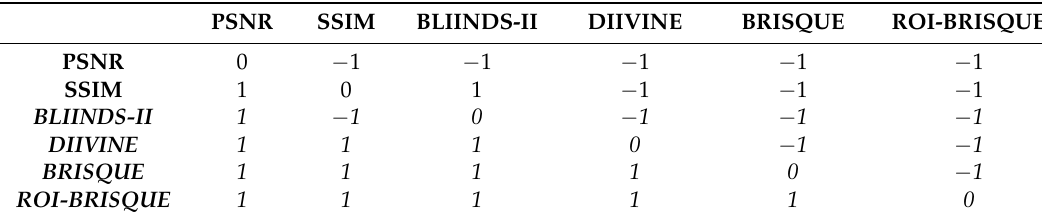
Table 6. Results of one-sided t-test performed between SROCC values of various IQA algorithms. The value of “1” indicates that the row algorithm is statically superior to the column algorithm; “ − 1” indicates that the row is inferior to the column; “0” indicates that the row and the column methods are equivalent. Italics indicate No-reference algorithms.